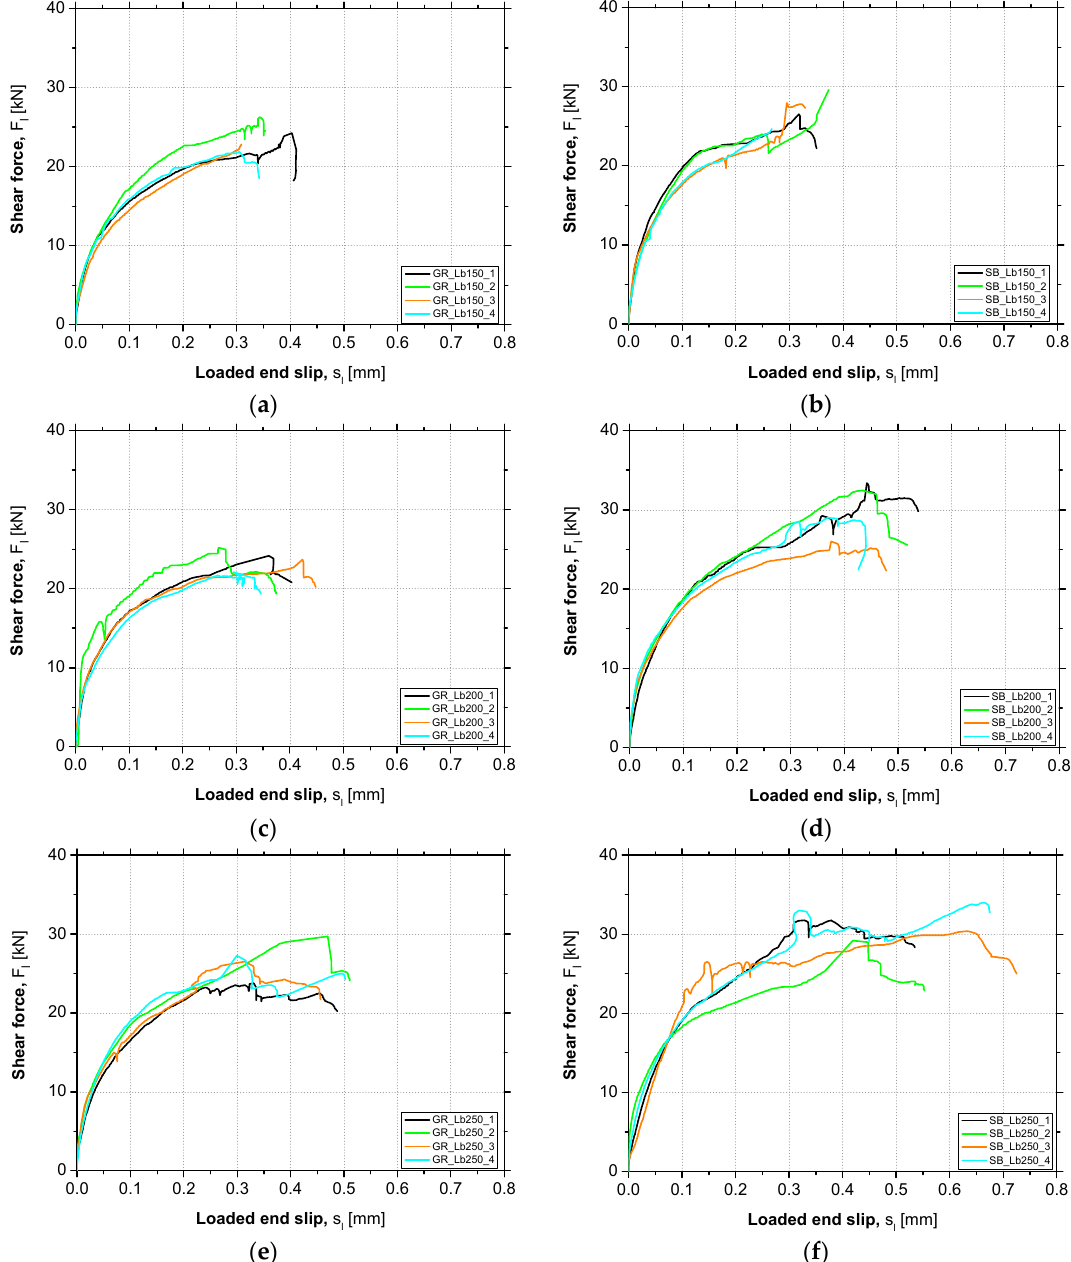
Figure 5. Shear force vs. loaded end slip obtained in each series: ( a ) GR_Lb150; ( b ) SB_Lb150; ( c ) GR_Lb200; ( d ) SB_Lb200; ( e ) GR_Lb250; ( f ) SB_Lb250.